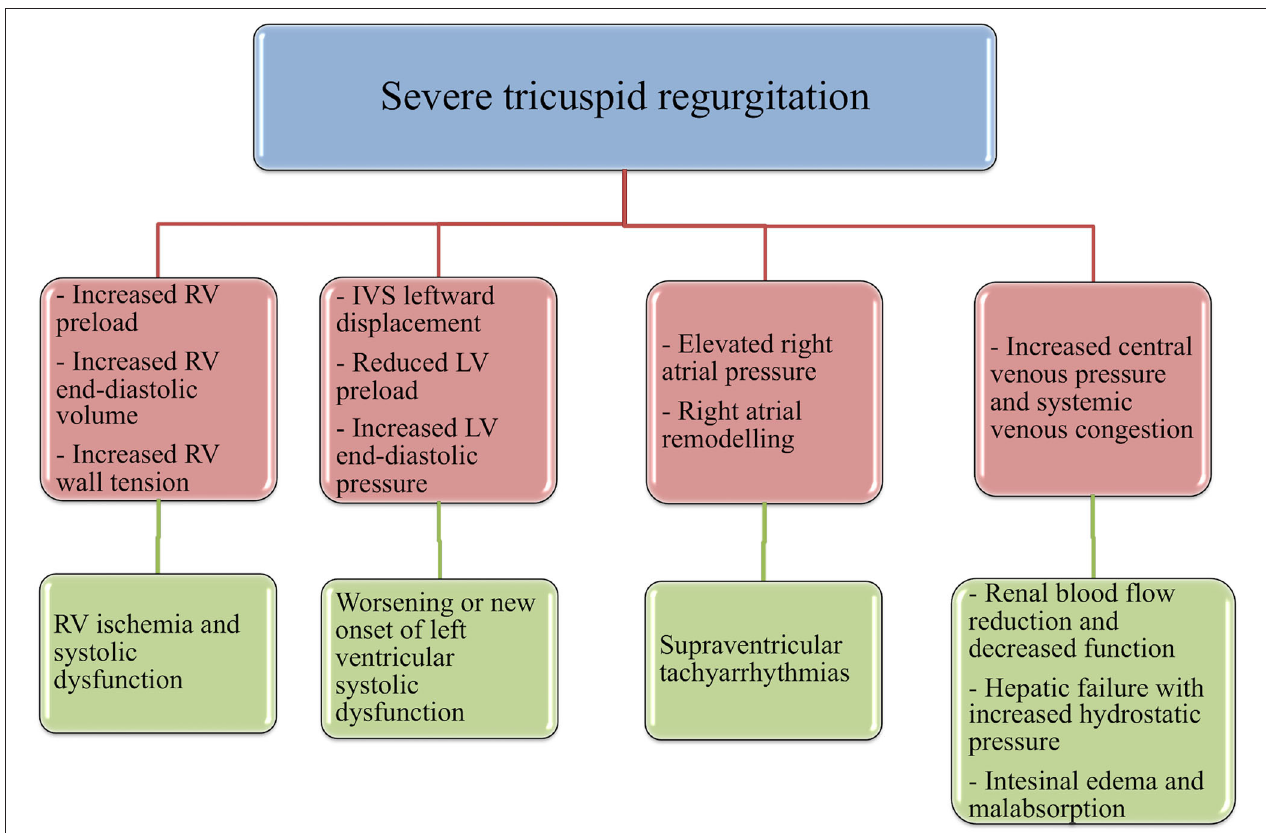
FIGURE 2 | Different pathophysiological mechanisms that may relate tricuspid regurgitation to an independent prognostic role in the context of LV systolic dysfunction. RV, right ventricle; LV, left